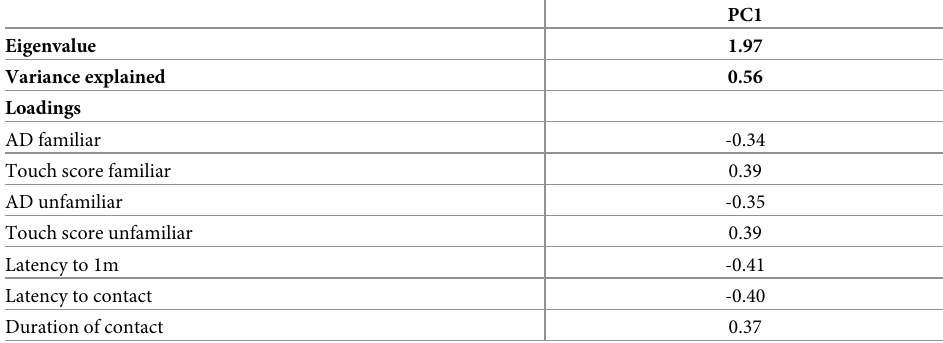
Table 1. Eigenvalue of the first principal component (PC1, denoted “relationship”) derived by the PCA on the outcomes of the behavioural tests, variance explained, and loadings of the behavioural